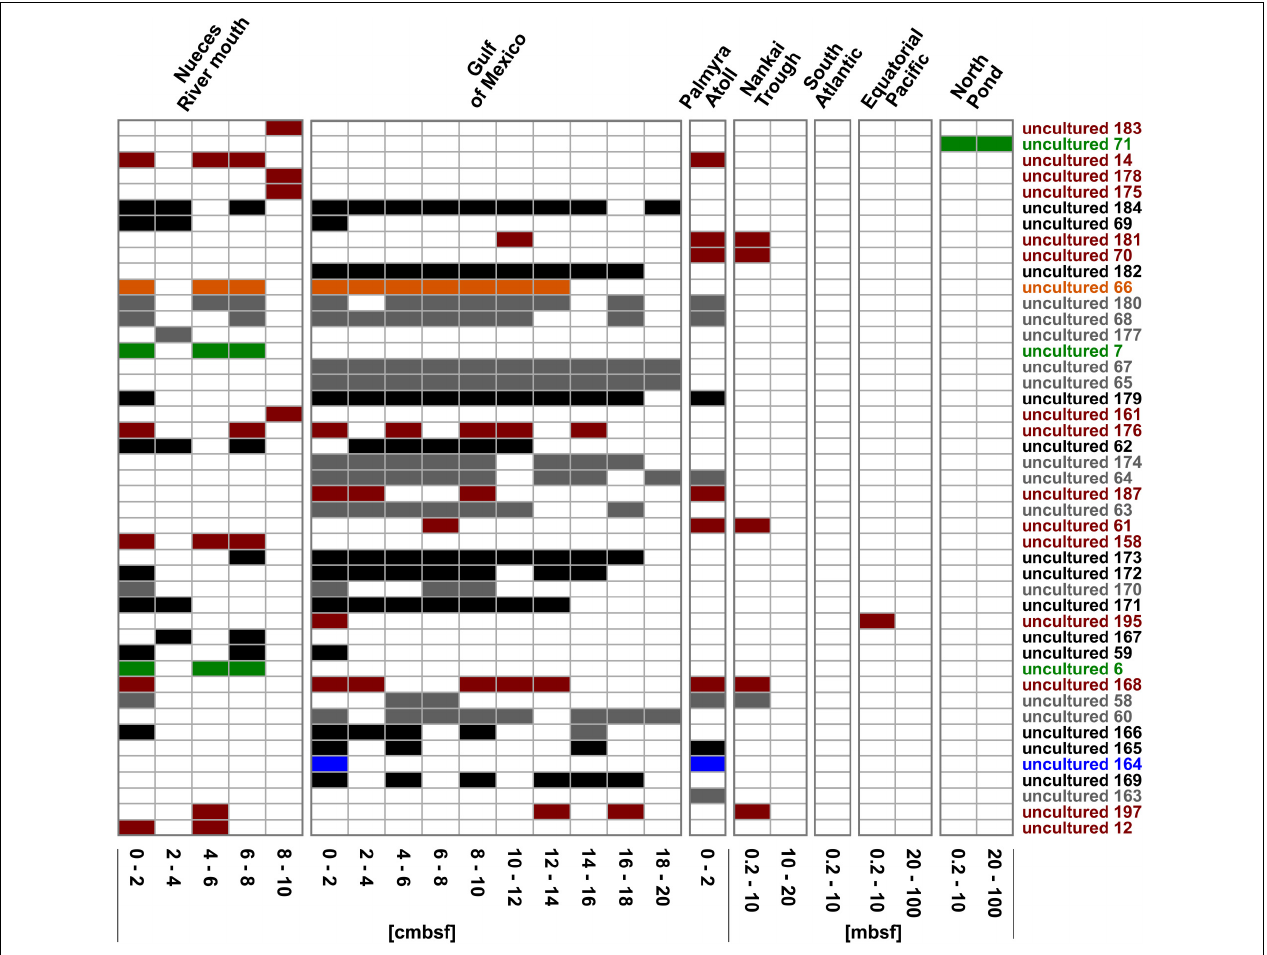
FIGURE 6 | Distribution of the OTUs affiliated to uncultured representatives within the Rhodobacteraceae . OTUs are sorted by their relative abundance on the total bacterial community. Sample locations are arranged by water depth and then by sediment depth. The affiliation of OTUs to the phylogenetic subgroups is displayed by red = Roseobacter , orange = Stappia , green = Amaricoccus , black = cluster I, gray = cluster II, and blue = unclear